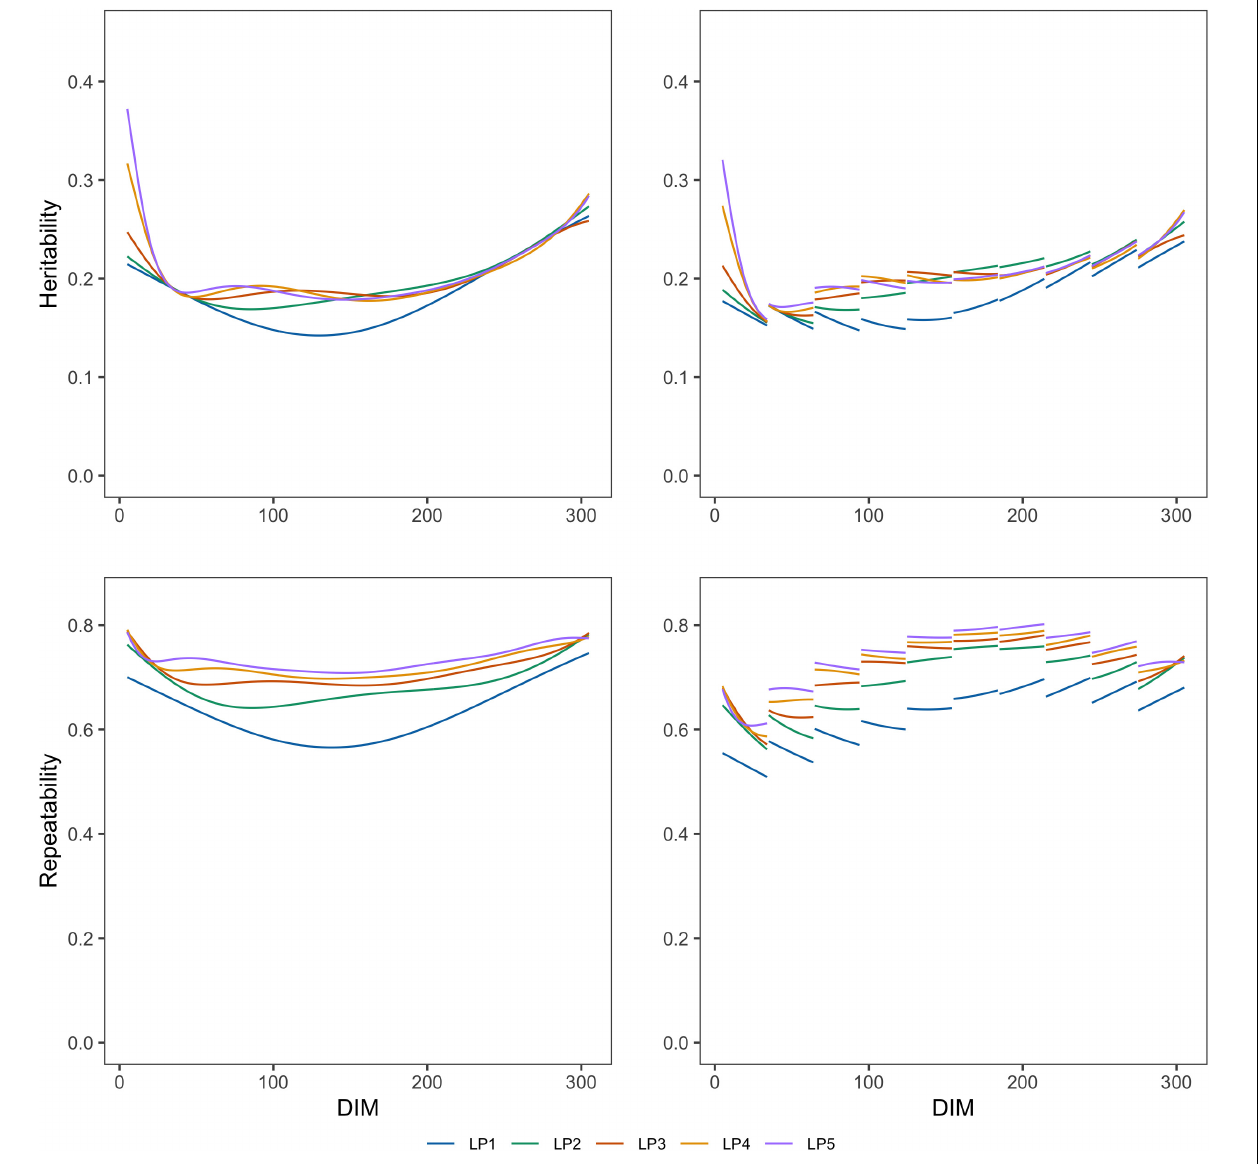
FIGURE 2 | Heritabilities and repeatabilities at each test day along the lactation from models with different orders of LP based on assumption of homogeneous (left column) or heterogeneous residual variance (right column).